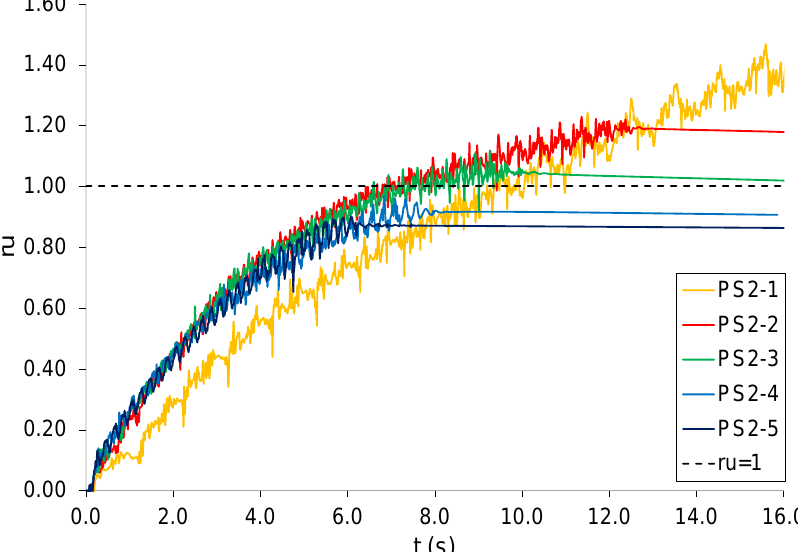
Figure 8. Pore pressure ratios versus time for parametric study PS2.